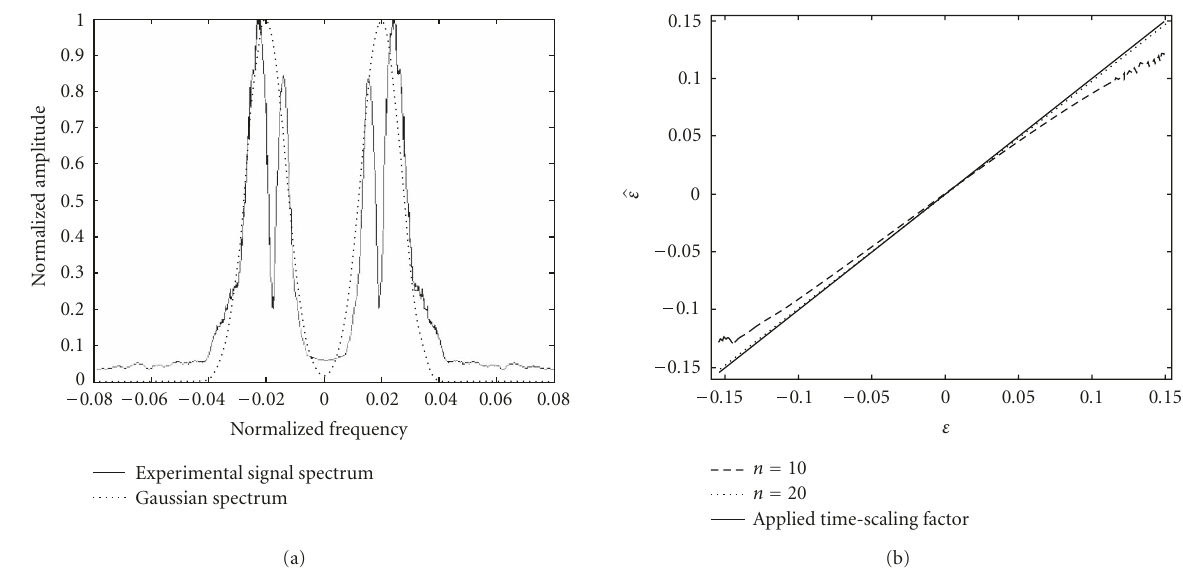
Figure 6: (a) Experimental signal spectrum; for comparison, the Gaussian spectra used in simulation is plotted behind. (b) Time-scaling factor estimated from ultrasound scanner signals. The second signal was artificially stretched from − 15% to 15%. The time-scaling factors were calculated with n = 10 iterations and n = 20 iterations. For comparison, the applied time-scaling factor is also plotted.